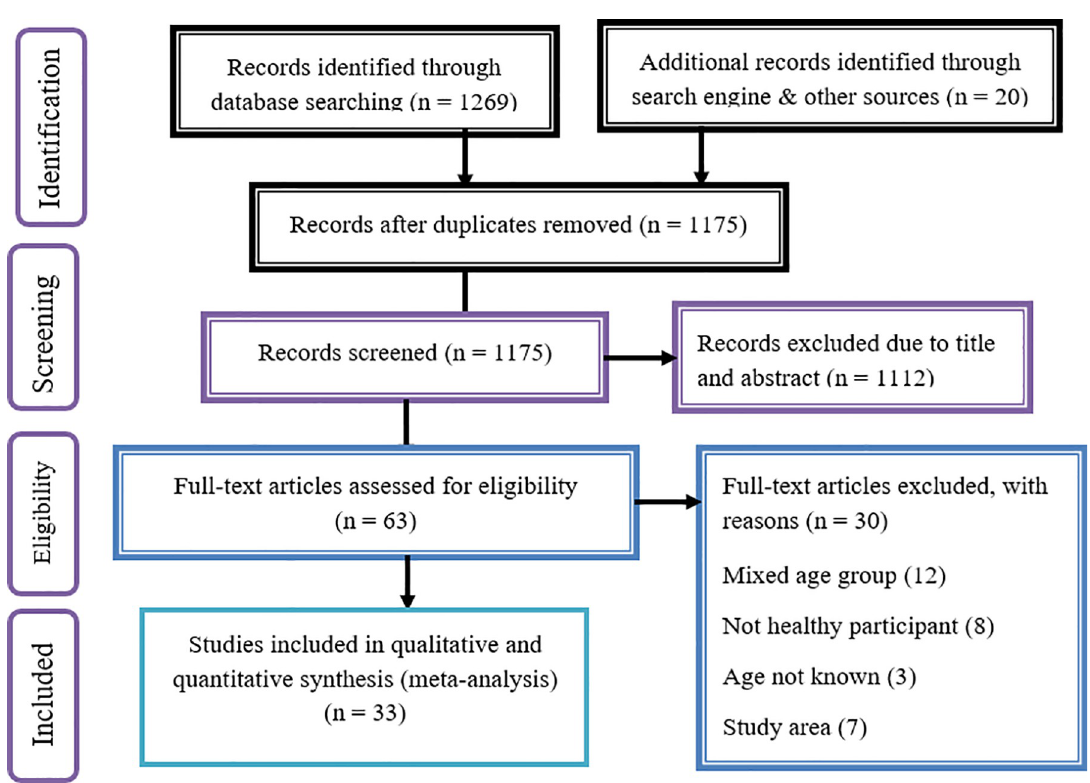
Fig 1. PRISMA 2009 flow diagram of study selection of adolescent double burden of malnutrition in Ethiopia.